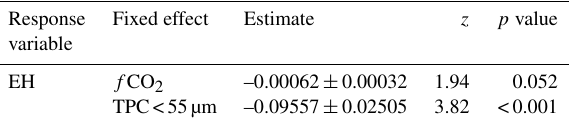
Table 4. Z statistics of the retained fixed effects in the GLMM test- ing the effect of f CO 2 , TPC (<55µm) and C:N on EH. Repeated measures of the same mesocosm bags were used as a random effect in the model, because copepods that come from the same bags are more alike than copepods from different bags.